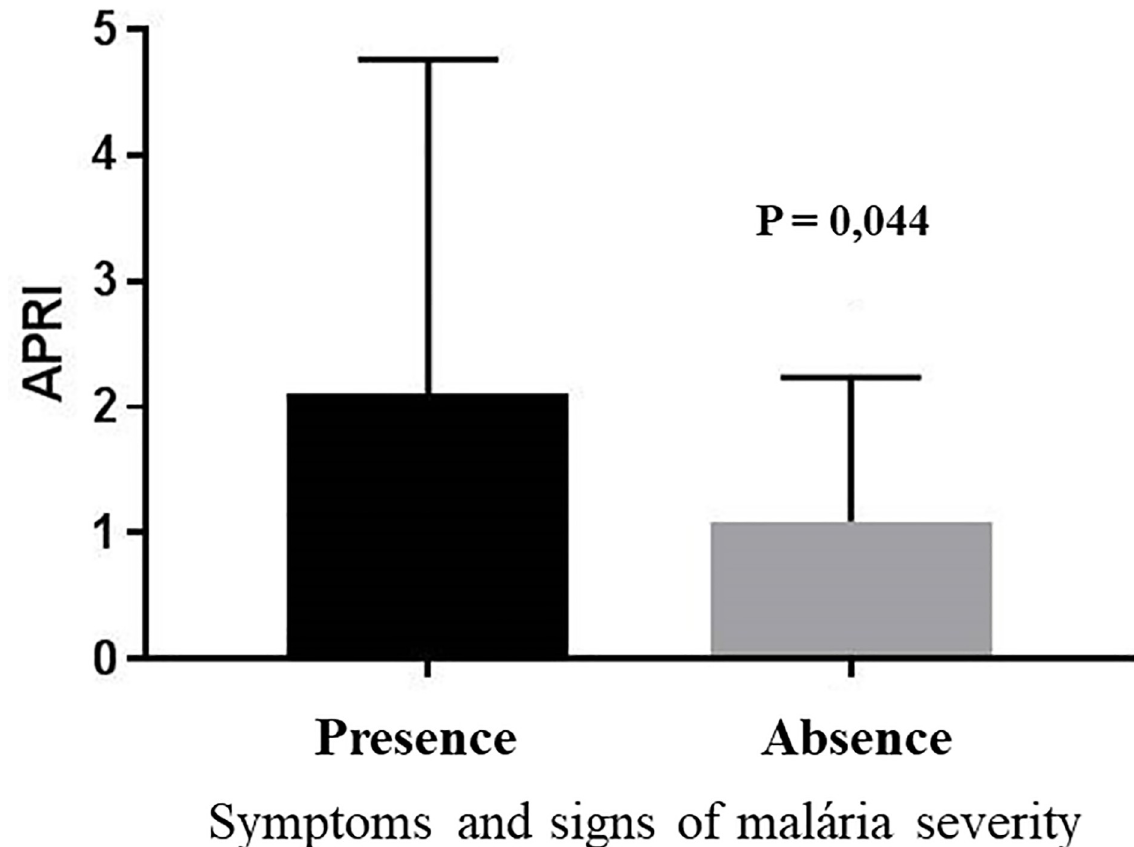
Fig 1. Aspartate aminotransferase-to-platelet ratio index (APRI) in patients infected with P . vivax with presence or absence of signs and symptoms of severe malaria.